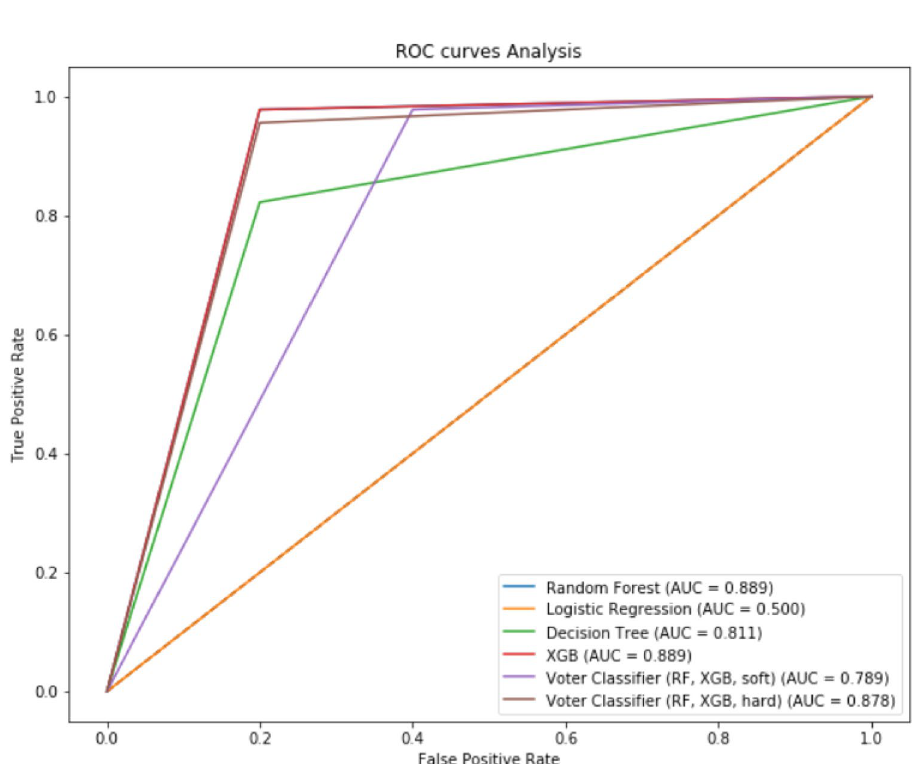
Figure 5. ROC curve analysis of different models in validation